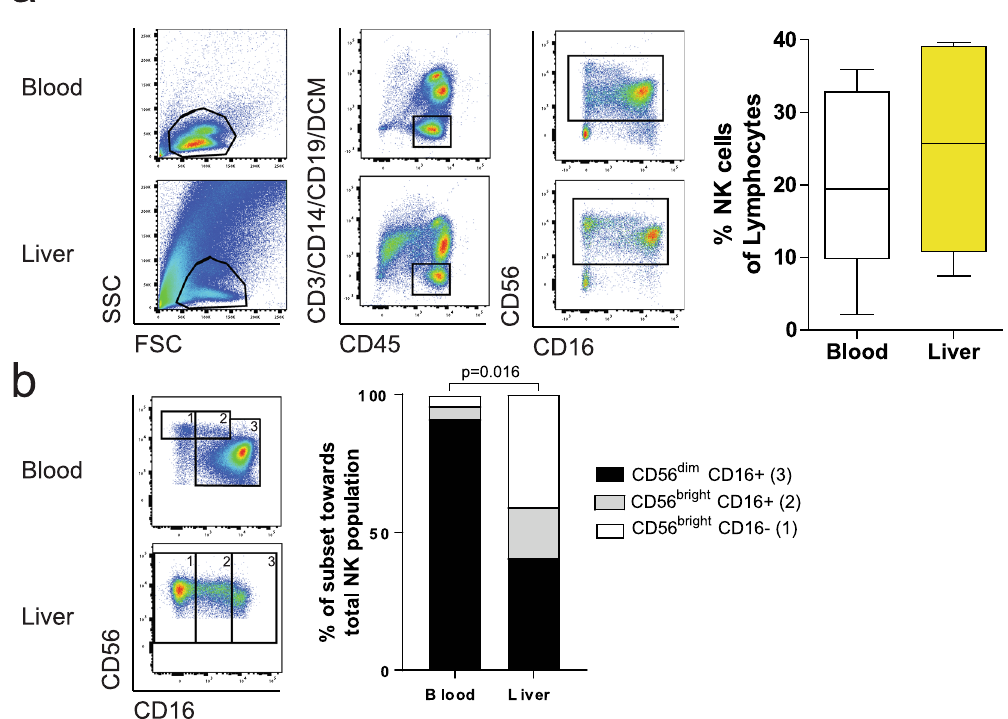
Figure 1. CD56 bright NK cells are enriched in human liver tissue. ( a ) Gating strategy (left panel) for identification of NK cells in peripheral blood (upper row) and liver tissue (lower row). Summarization of the data (right panel) comparing frequency of NK cells in blood and liver from matched patient samples (n = 7). Box and whiskers (Tukey) plots was used. ( b ) Identification of CD56 dim (3), CD56 bright CD16 + (2) and CD56 bright CD16- (1) NK cells (left panel) in peripheral blood (upper plot) and liver tissue (lower plot). Summarization of the data (right panel) comparing CD56 dim ,CD56 bright CD16 + and CD56 bright CD16- NK cells in the blood and liver of matched patient samples (n = 7). Bars show the median for all individuals, Wilcoxon matched pair sign rank test was used to determine statistical